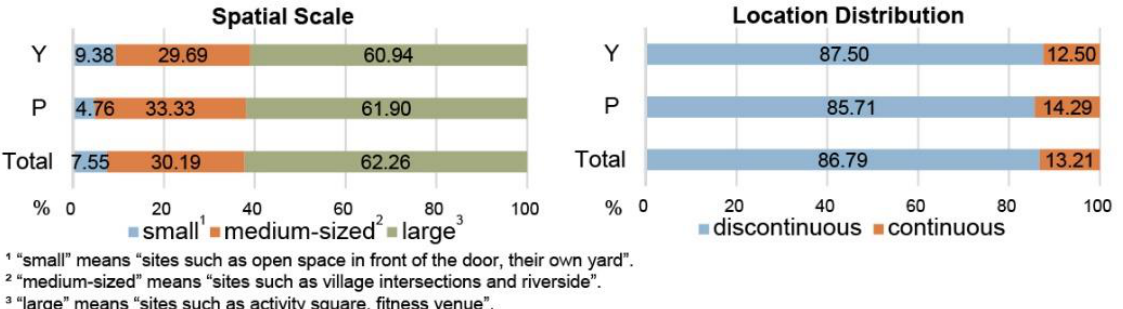
Figure 4. Survey statistics of respondents ’ spatial scale preferences.